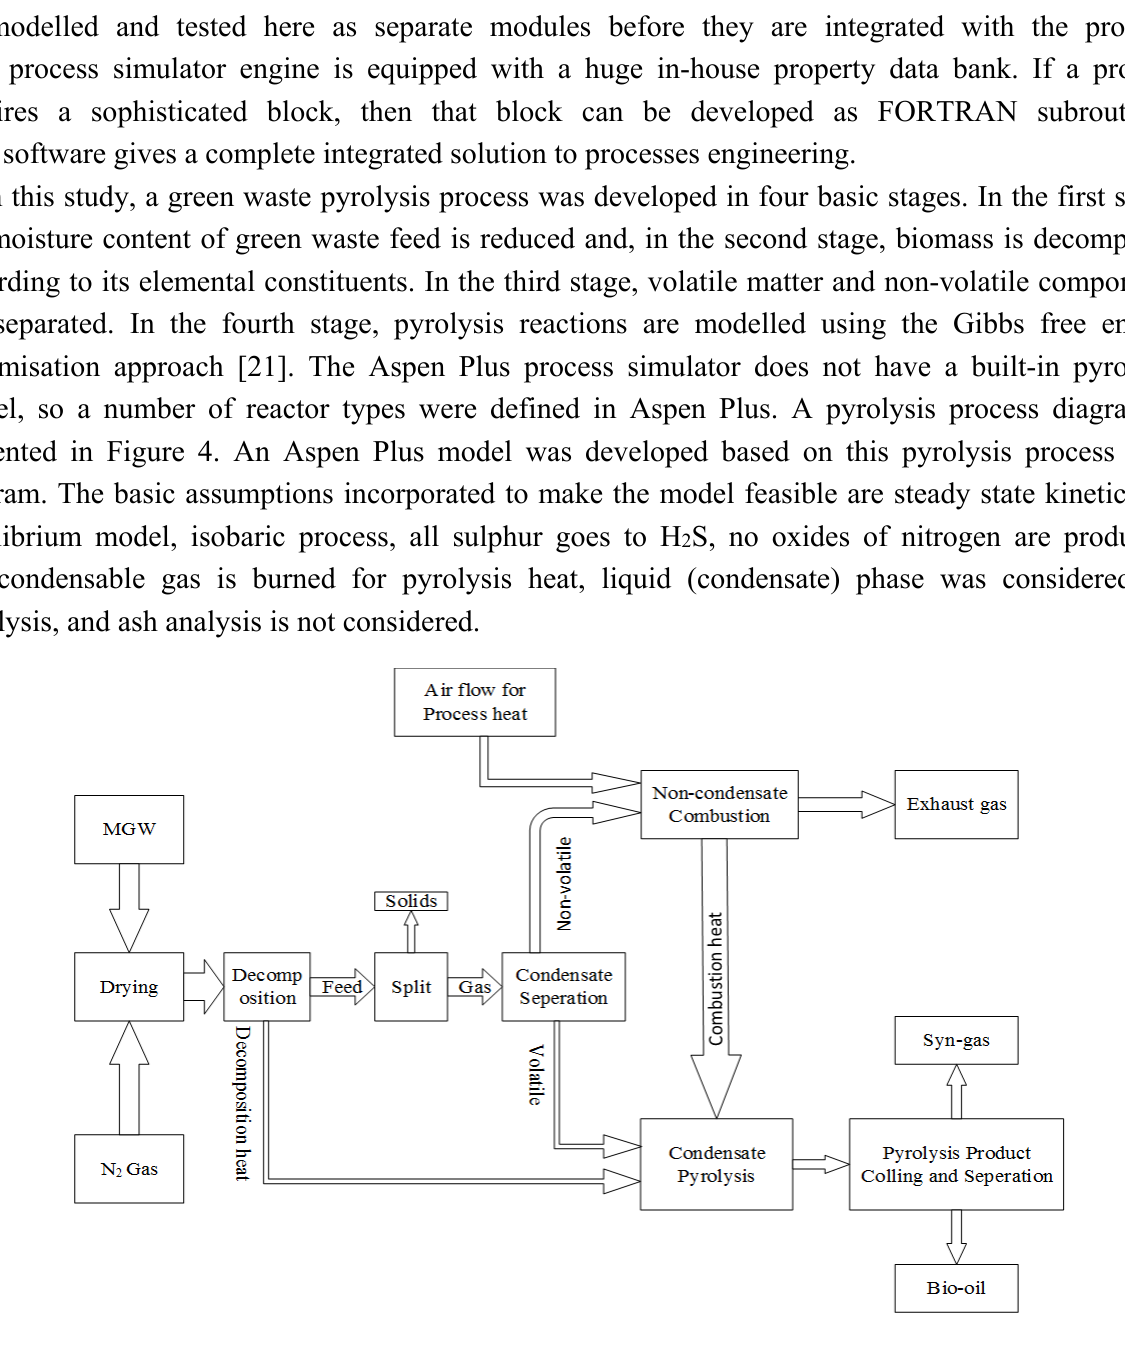
Figure 4. Flowsheet of MGW